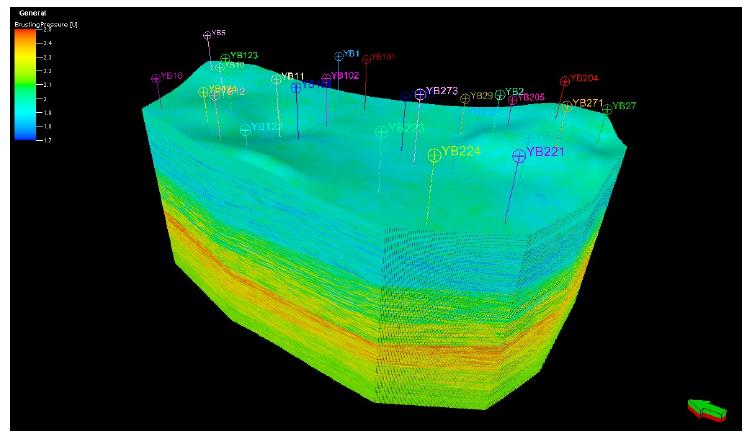
Figure 4. Structural level model.